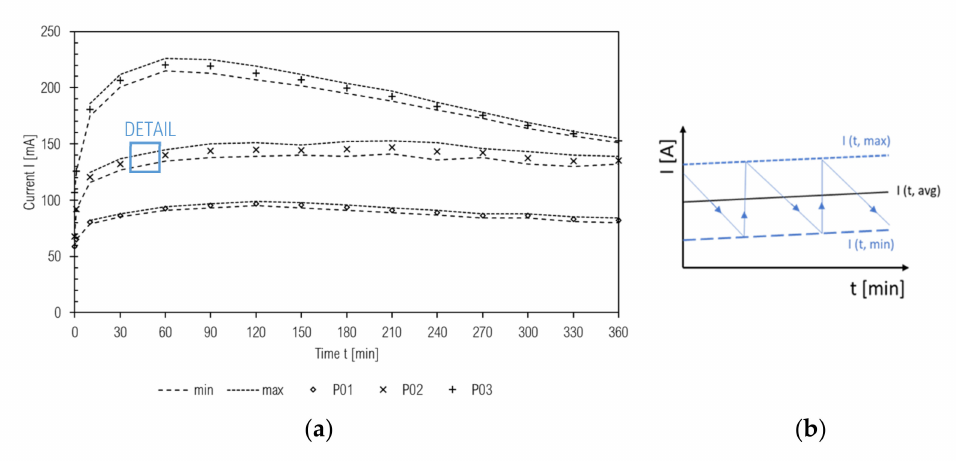
Figure 14. ( a ) Current development in the RCP test; ( b ) schematic detail of current